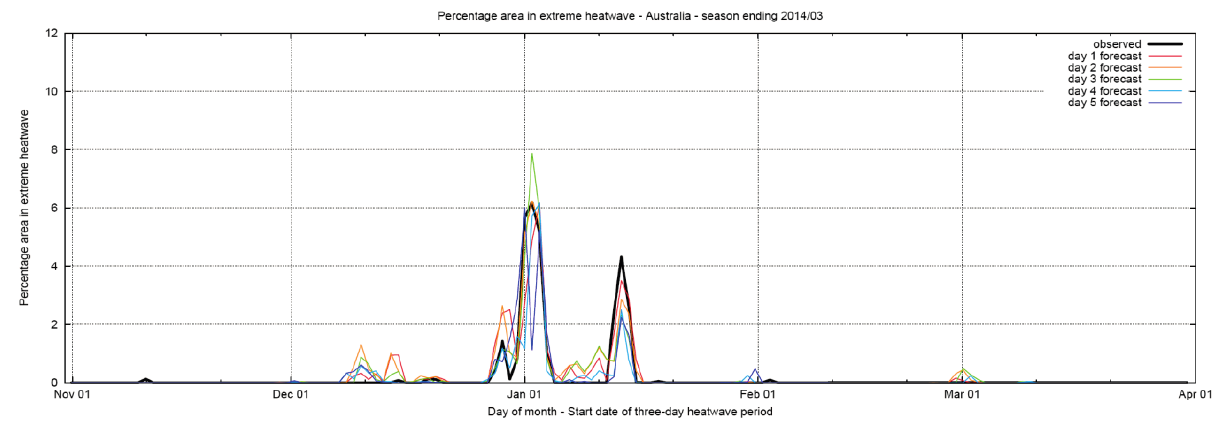
Figure A3. As per Figure A2 but for percentage area in severe heatwave.